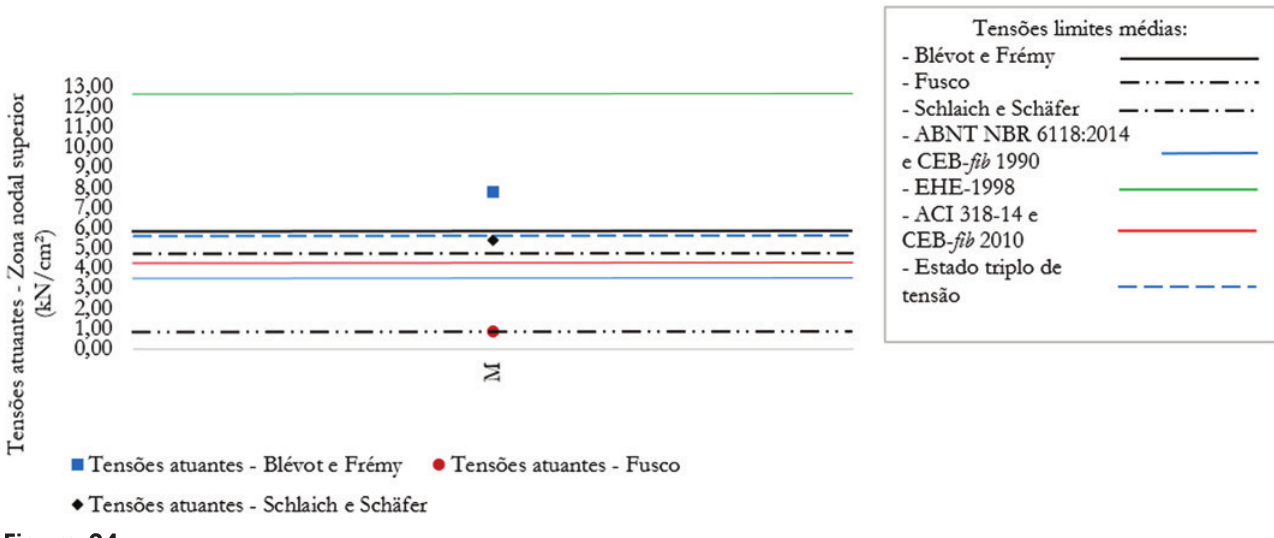
Modelos ensaiados por Mesquita [12] × σ